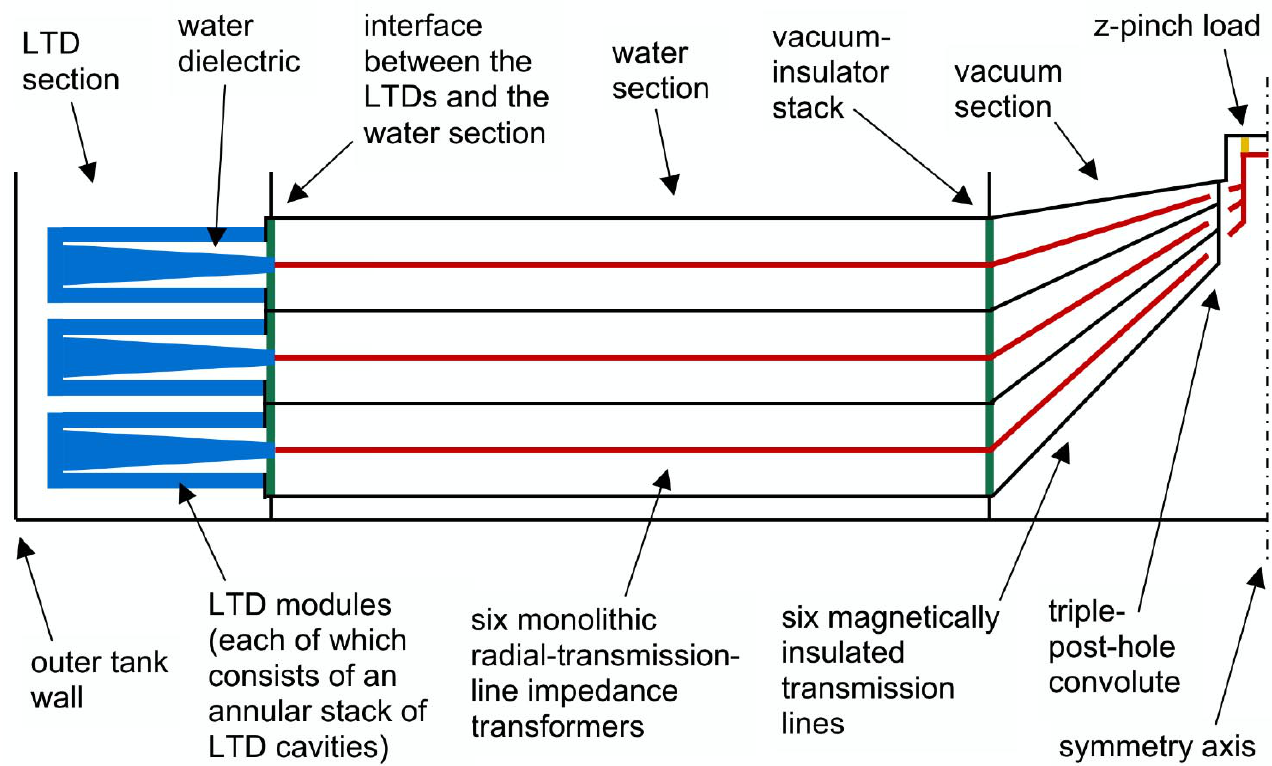
FIG. 3. (Color) Conceptual design of an LTD-based petawatt-class z -pinch driver. The design illustrated here is identical to that outlined in Fig. 1, except that the Marx generators, intermediate stores, and gas switches of Fig. 1 have been replaced by linear transformer drivers (LTDs) [60,74–76,79–102]. The anode-cathode gaps of the water-insulated transformers are shown here as being independent of radius; however, the actual gaps would likely vary with radius to achieve an exponential impedance profile. (The drawing is not to